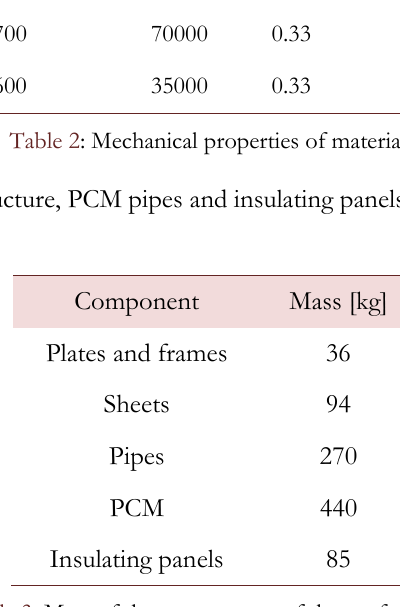
Table 3: Mass of the components of the roof